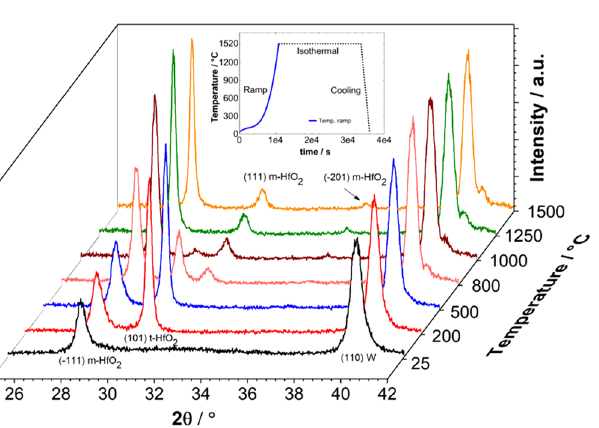
Figure 2. Diffraction patterns of the two identical 3-layer-systems: 100 nm HfO 2 /20 nm W/100 nm HfO 2 , measured before and after annealing at 650 °C ( a ) and 1520 °C ( b ) for 6 h.